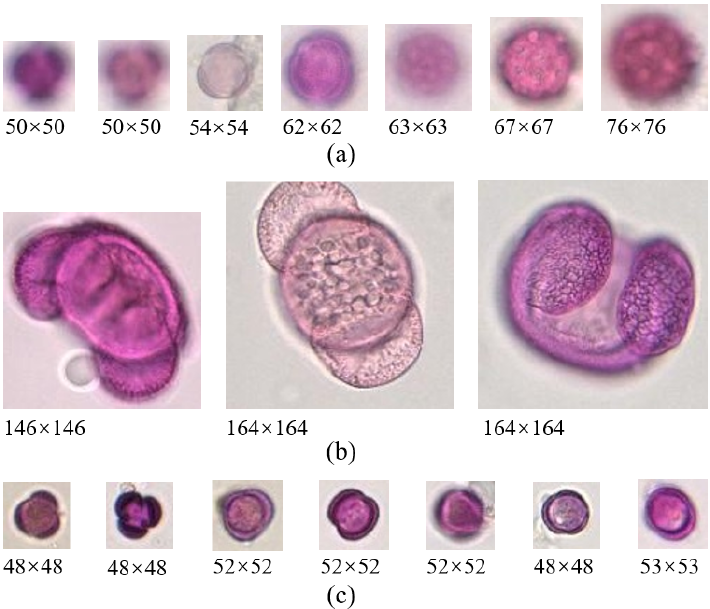
Figure 4. Several example pollen grain images: ( a ) pollen grain images with unclear details;